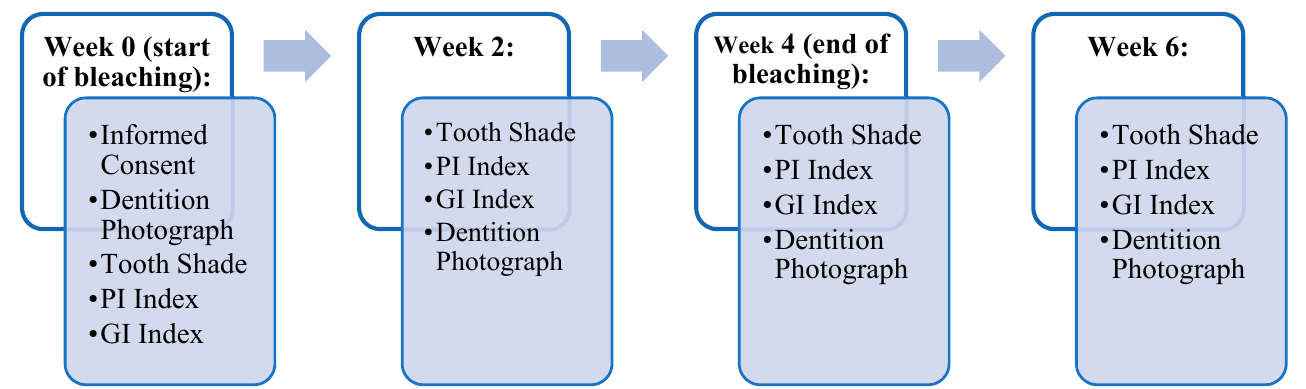
Figure 1. Periodic examinations were conducted bi-weekly to measure the progress of subjects’ oral health.